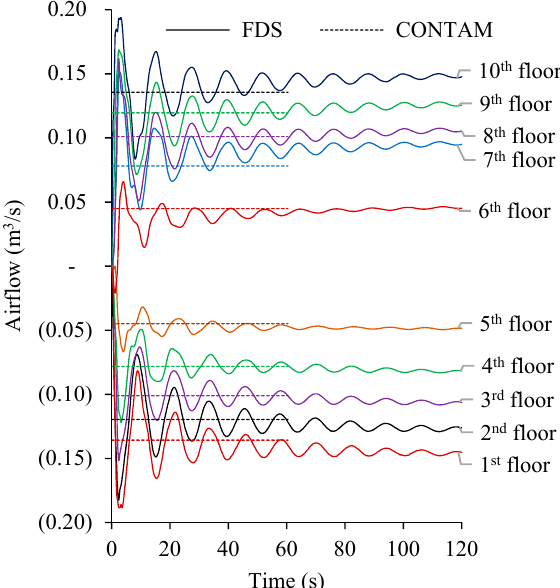
Figure 11. CONTAM and FDS results for airflow at vertical shafts, simulation: average stairwell and leaky envelope.